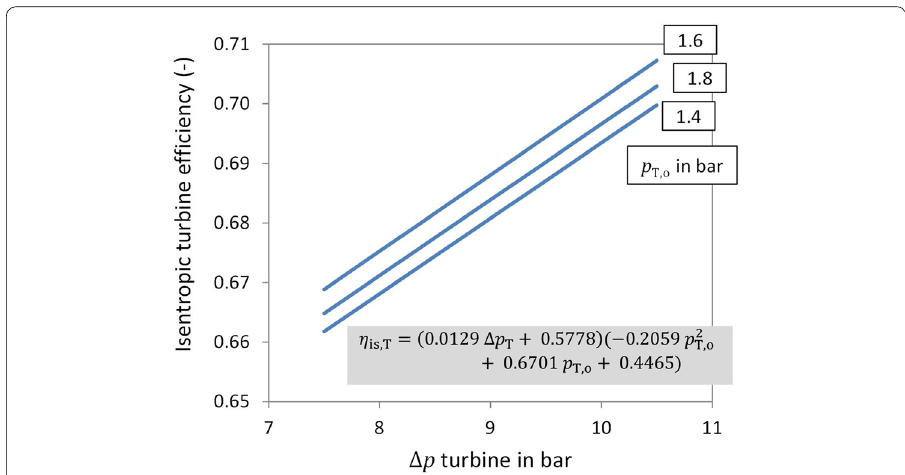
Fig. 12 Isentropic turbine efficiency estimate derived from real plant data